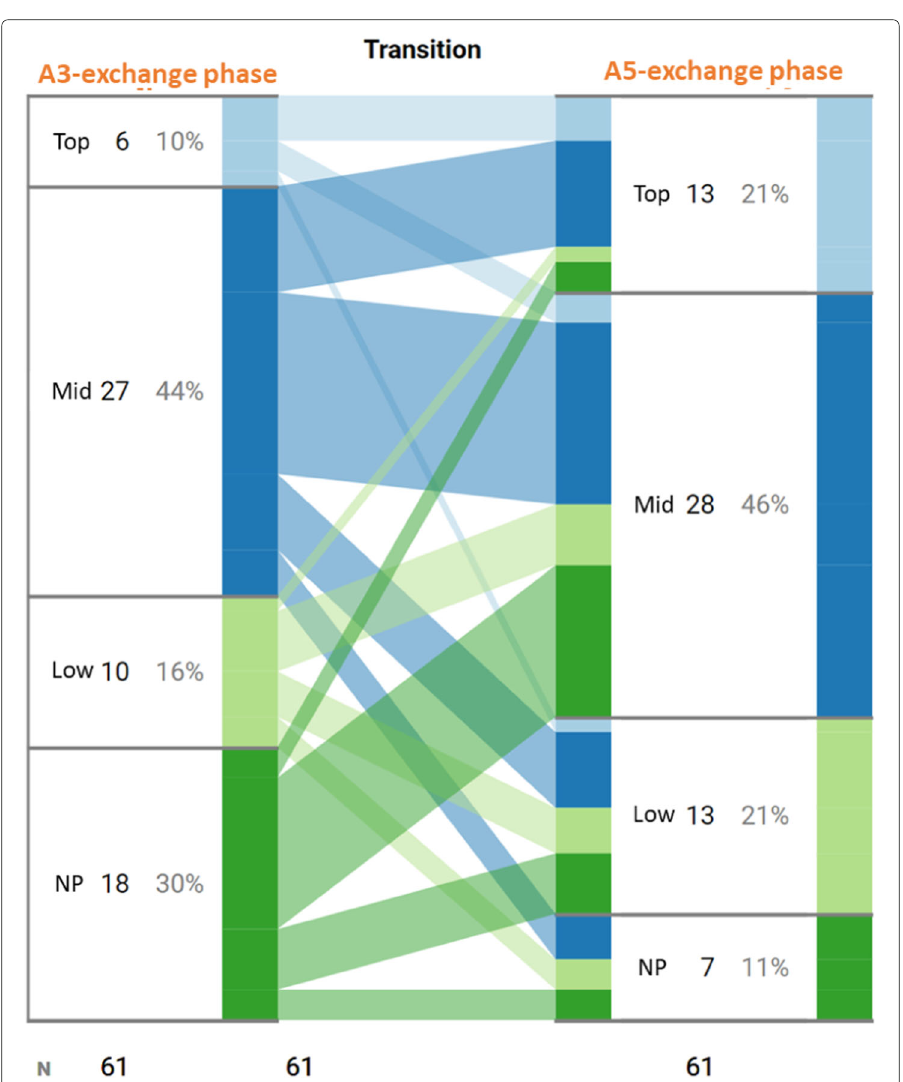
Fig. 11 Transition patterns of utterance duration in knowledge exchange phase between activity A3 and